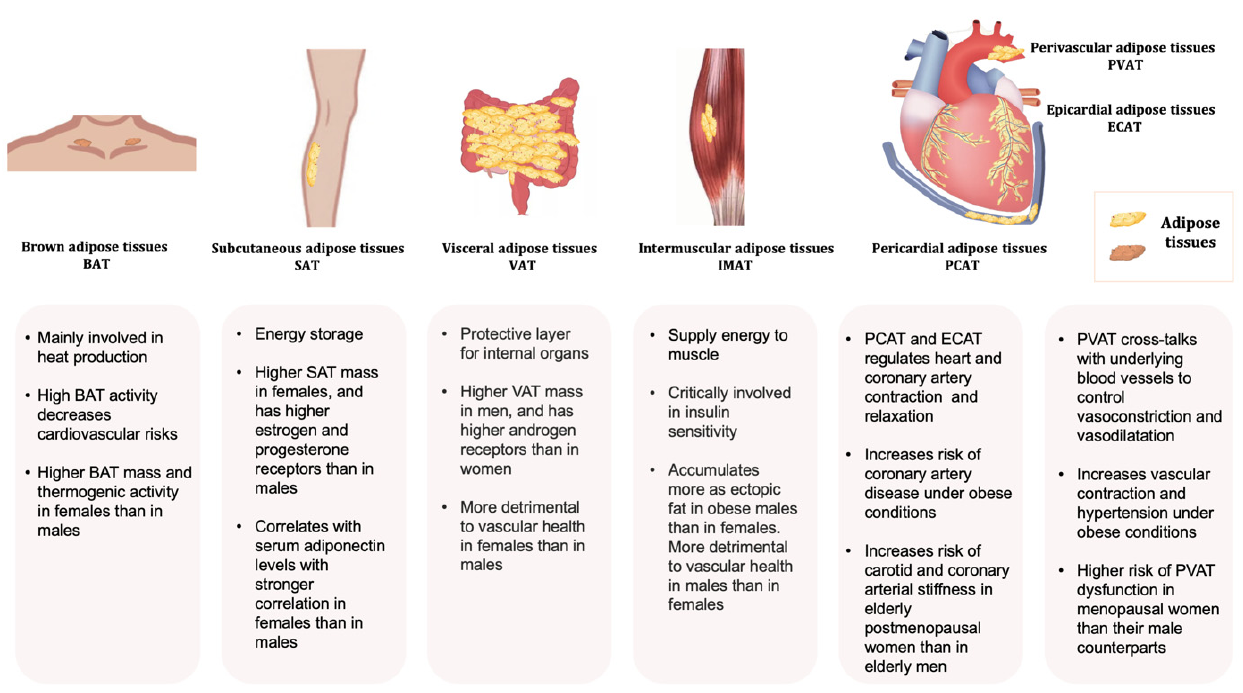
Figure 1. Typical adipose tissues, main functions, and some sex-related differences.